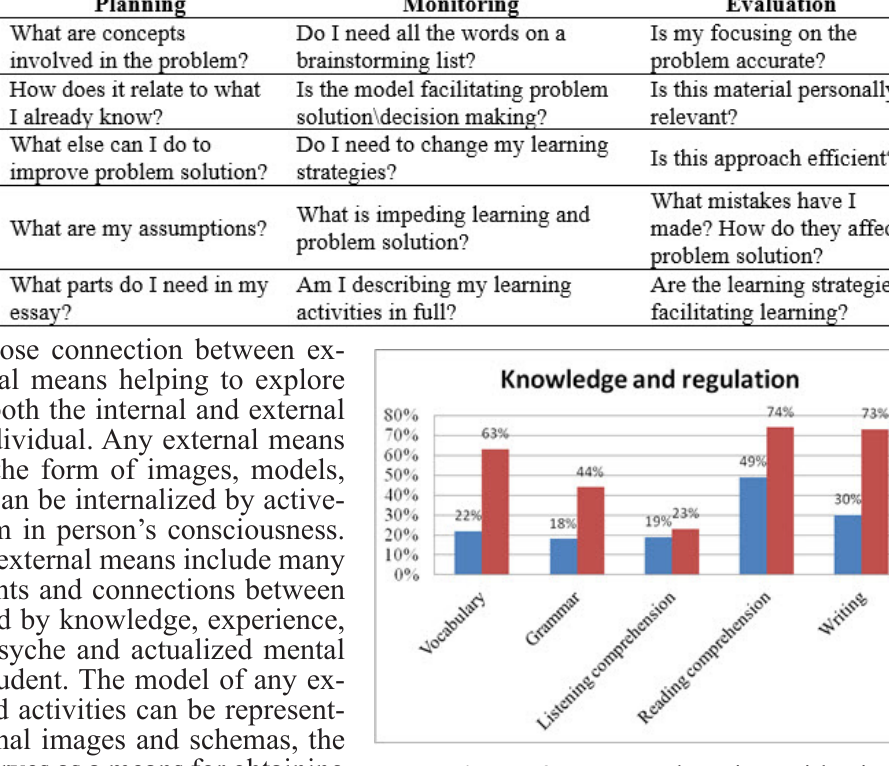
Figure 3. Repeated testing with